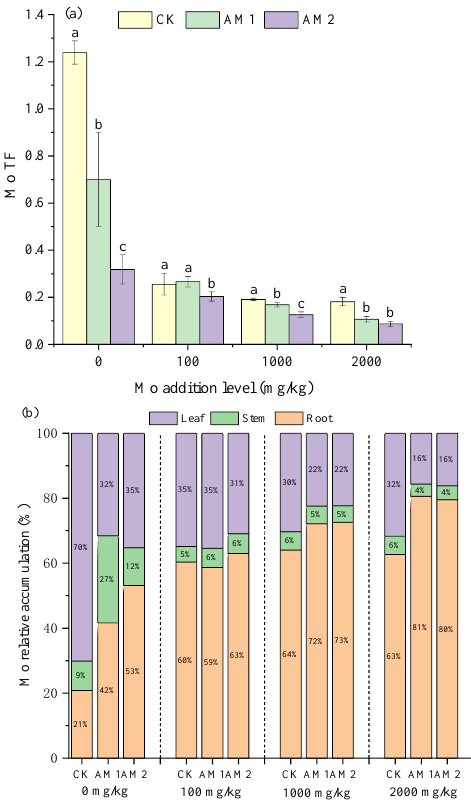
Figure 3. Translocation factor ( a ) and relative accumulation ( b ) under different levels of Mo addition in maize. Different lowercase letters above the bars indicate significant differences under the different inoculation conditions at the same level of Mo addition, determined using a one-way ANOVA fol-lowed by Duncan’s multiple range test ( p < 0.05). 3.4. Effects of AMF on Photosynthetic Parameters of Maize under Different Degrees of Mo Stress AMF inoculation significantly improved the net photosynthetic rate of maize plants at each Mo addition level (Figure 4). With the increase in the Mo addition level, the net photosynthetic rate under non-inoculation treatments showed a downward trend. The highest net photosynthetic rate of 18.53 μmol m −2 s −1 occurred at the Mo addition level of 100 mg/kg with AM2 inoculation. The net photosynthetic rate of maize showed a result of AM2 > AM1 > CK when the Mo addition levels were 0, 100, and 1000 mg/kg. creased the Chl a and carotenoid contents but decreased the Chl b content in maize plants